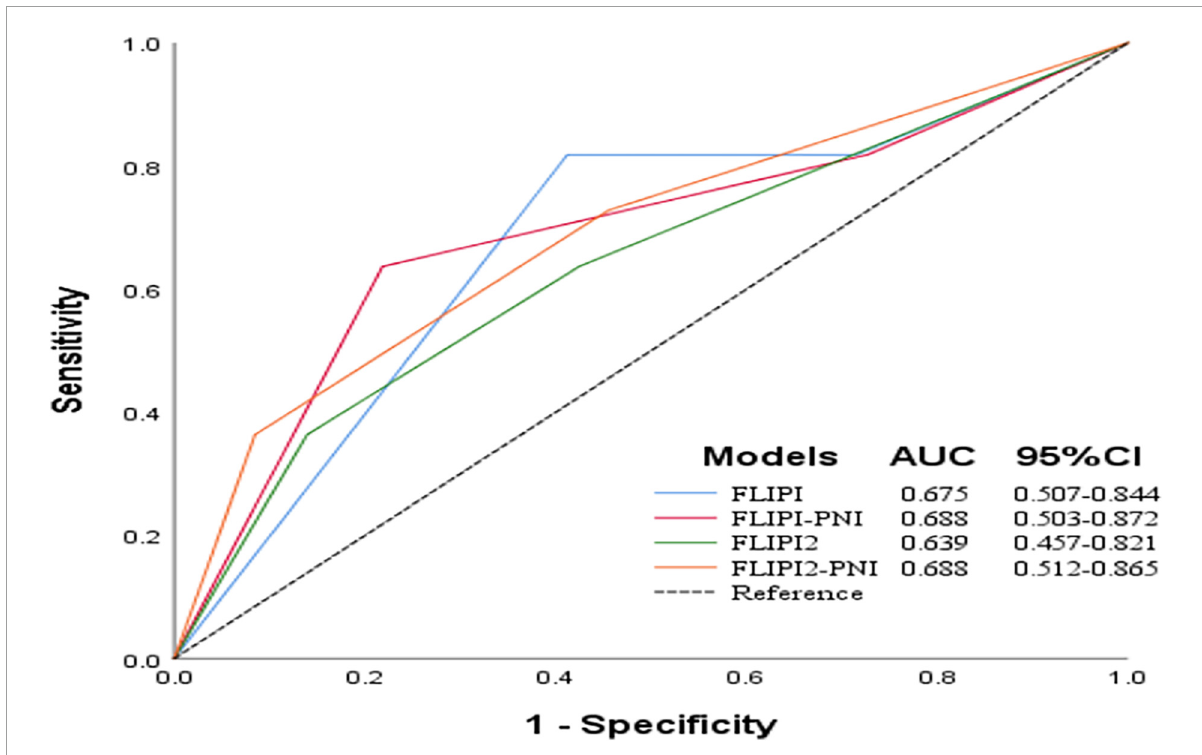
FIGURE5 Before and after integrating the PNI with AUC of models for predicting